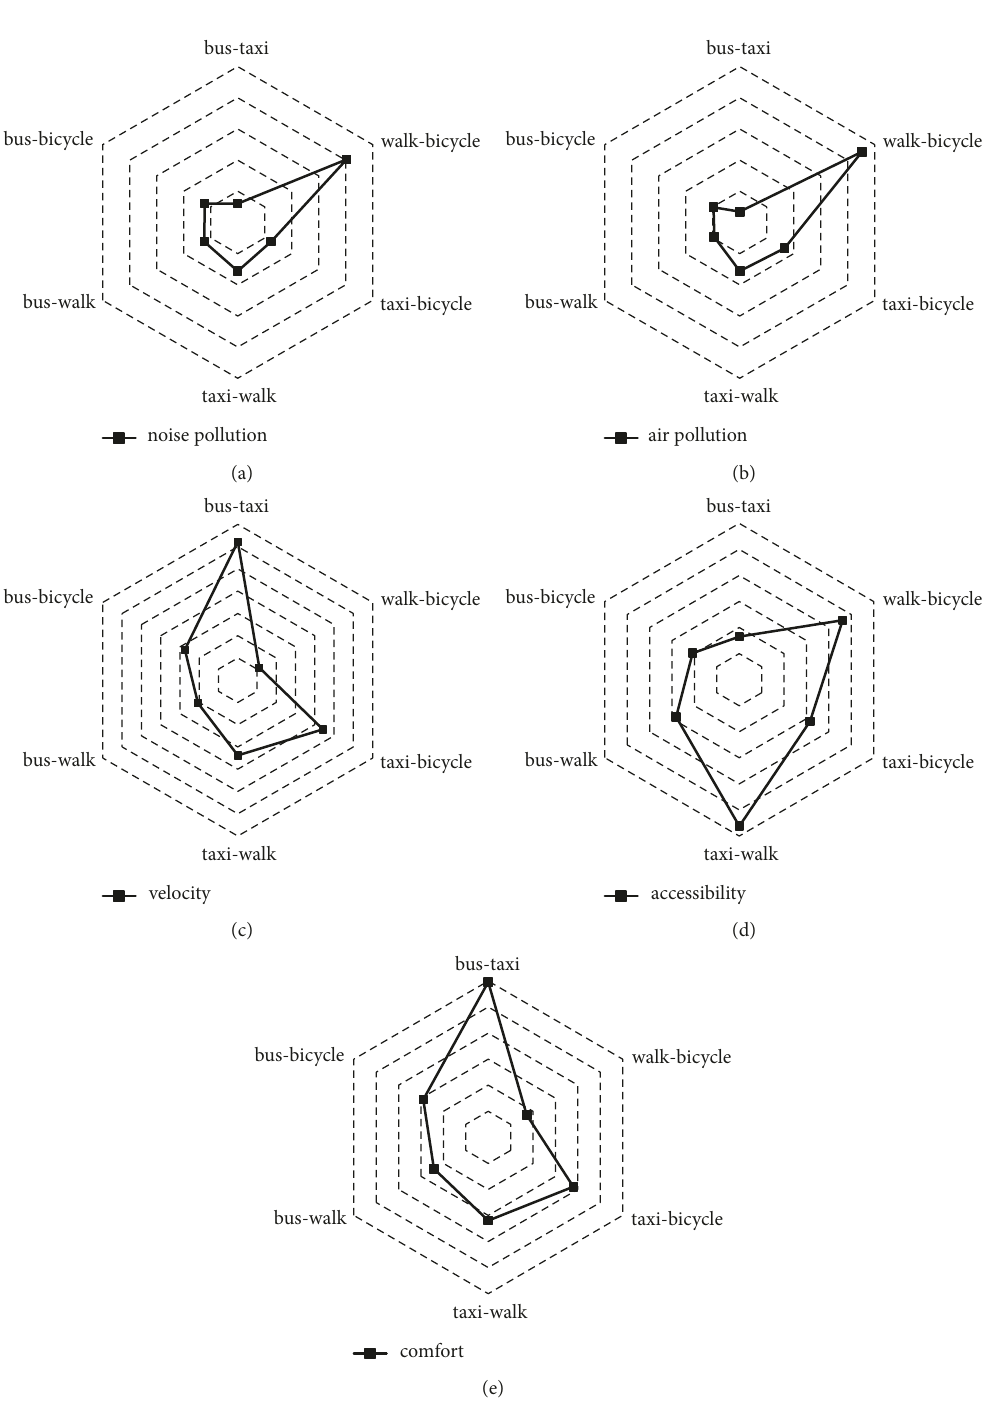
Figure 5: Prioritization of options regarding different